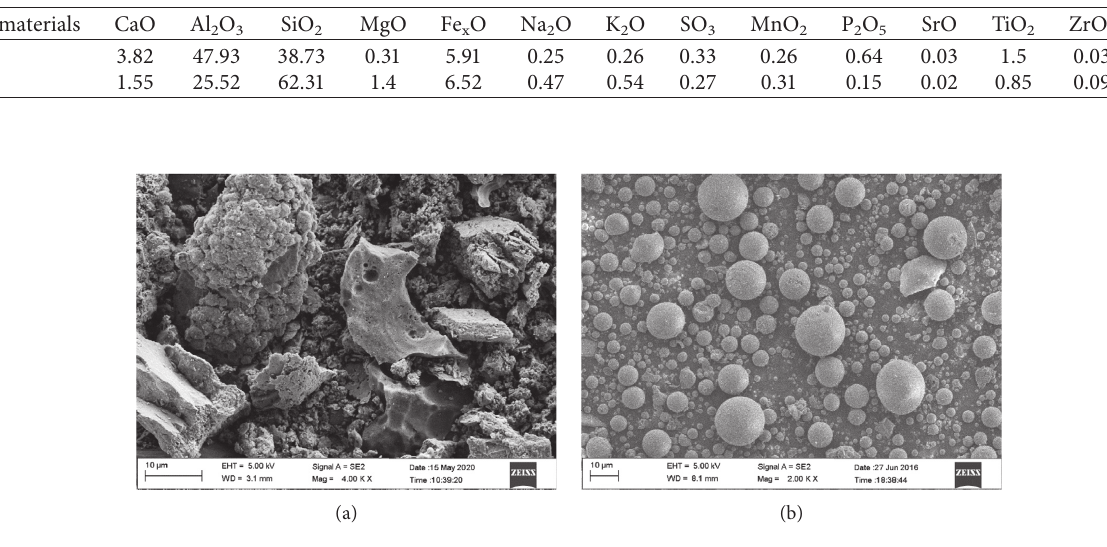
Table 3: Chemical compositions of the raw FA.